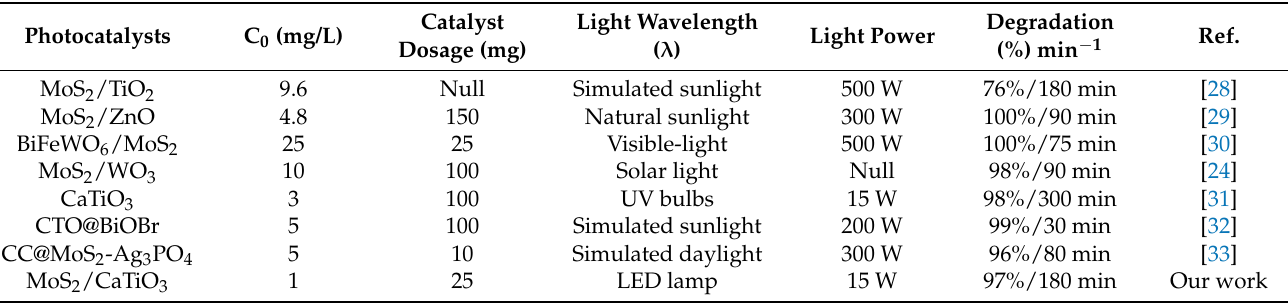
Figure 7. ( a ) The cycle curve of the MoS 2 modified CaTiO 3 (MCTO-2); ( b ) the histogram of the sample. Table 3. Photocatalytic RhB performances of different photocatalysts.